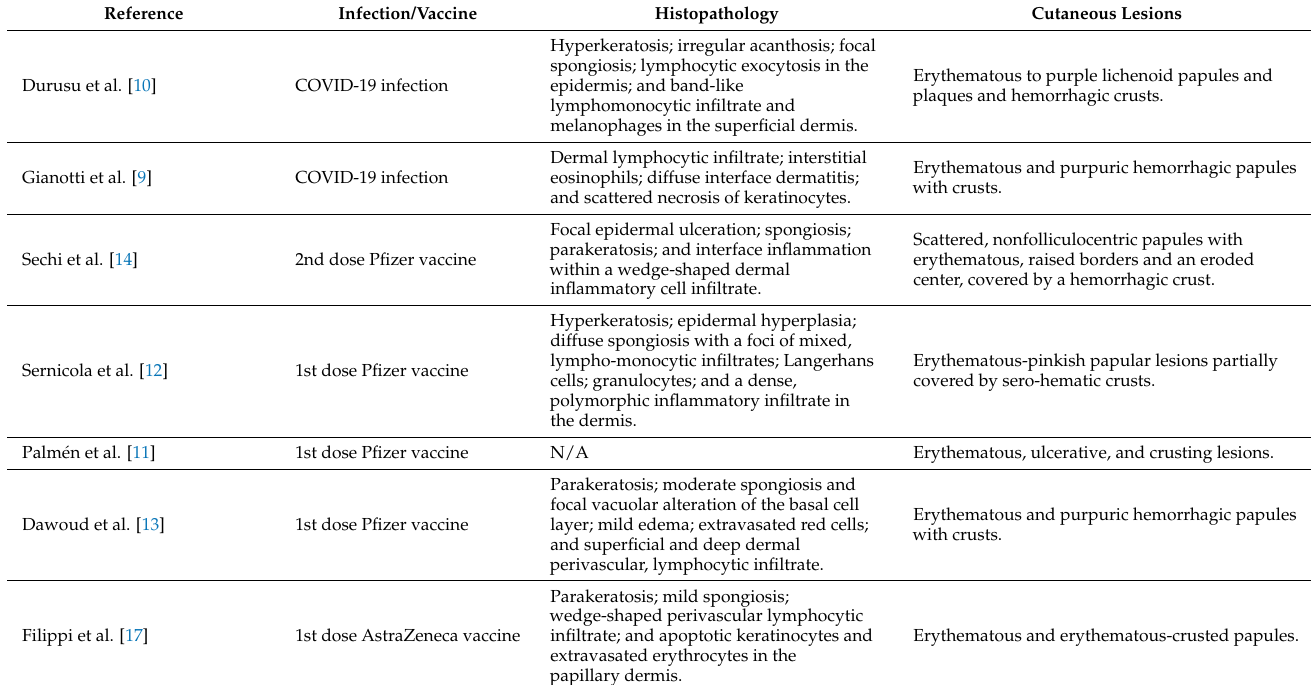
Table 1. Summary of a COVID-19 infection and vaccine-induced